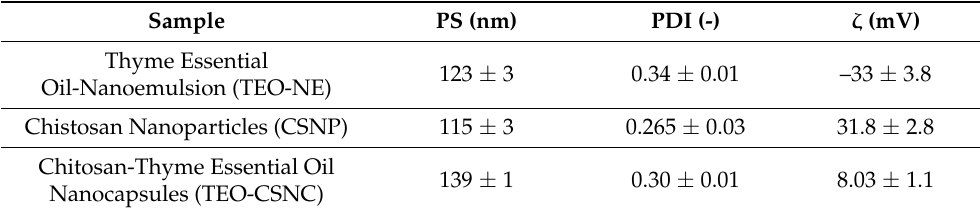
Table 1. Characterization by dispersion of laser light and electrophoretic movement of colloidal